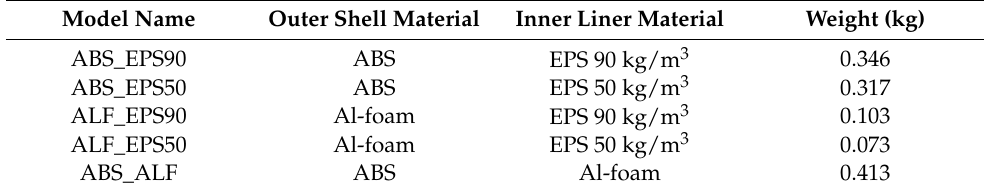
Table 1. Helmet model with various combination of materials.